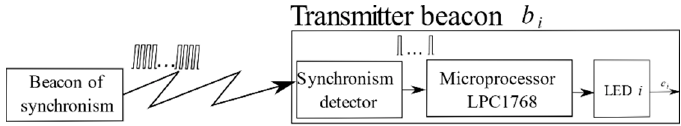
Figure 2. Block diagram of the transmission system.